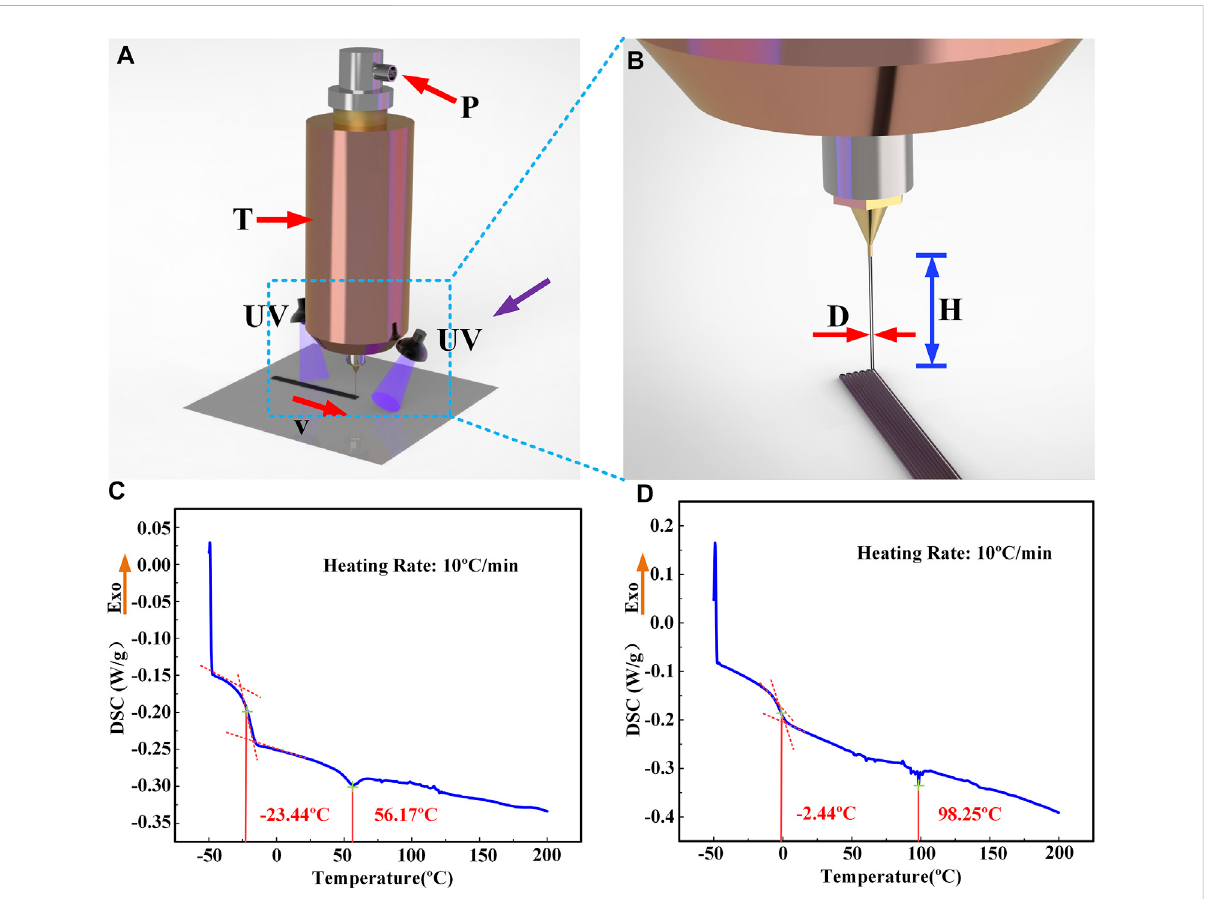
FIGURE 2 DIW printing process and printing parameters of LCE: the ink is made of an LC oligomer, which is extruded along the moving direction of the nozzle after being heated in the printer and simultaneously cured by UV. The involved process parameters include v (printing speed), T (printing temperature), P (extrusion pressure), H (printing height), and D (nozzle diameter). (A) The DIW macro printing process in its entirety. (B) The nozzle and printing materials are partially enlarged to demonstrate the extruded fi ber and printing path. (C) DSC test of the LCE ink. (D) DSC test of cured LCE.